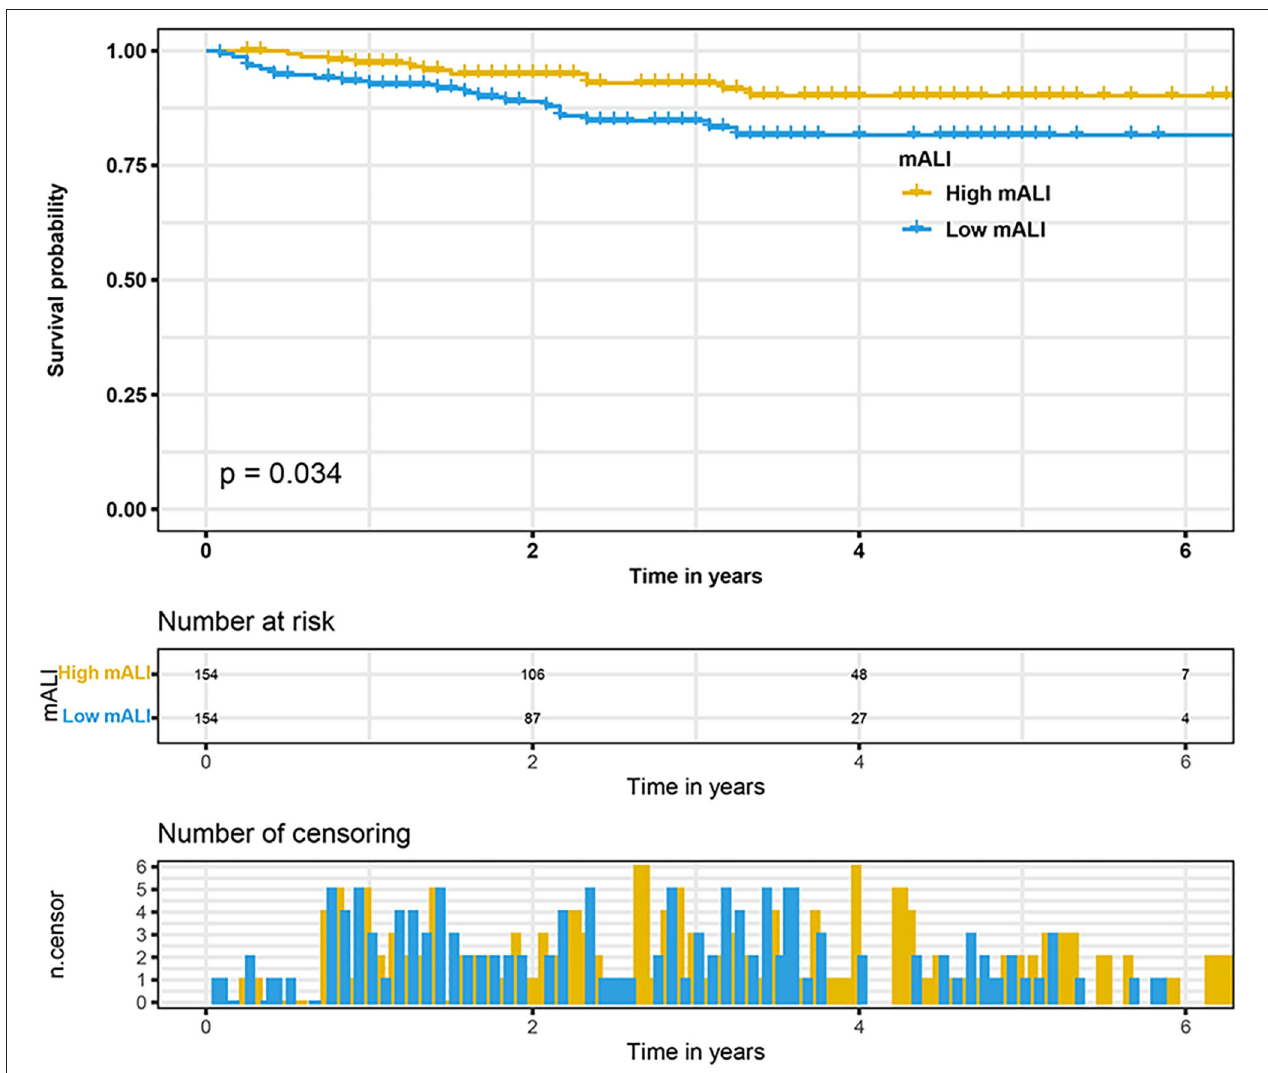
FIGURE 5 | Kaplan-Meier curves for OS stratified by mALI after PSM. OS, overall survival; mALI, modified advanced lung cancer inflammation index; PSM, propensity score matching.